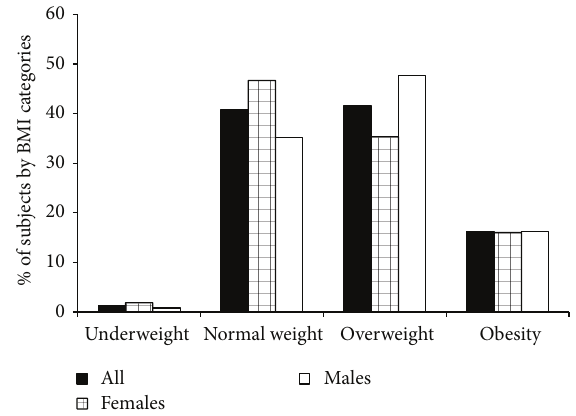
Figure 2: Distribution of > 60 all, females, and males by BMI categories. Percentage per each group has been calculated over the total number of > 60 years of age in all, females, and males groups